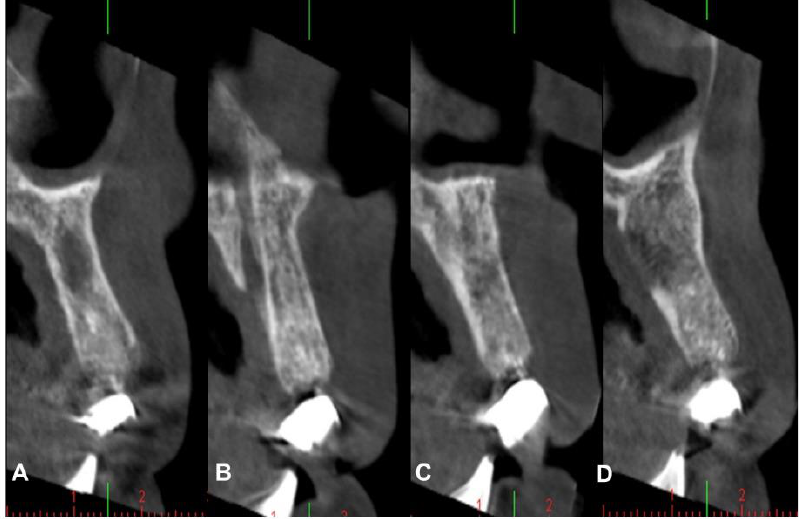
Figure 16. Postoperative CBCT after 4 months. (A) 12 (B) 11 (C) 21 (D) 22.